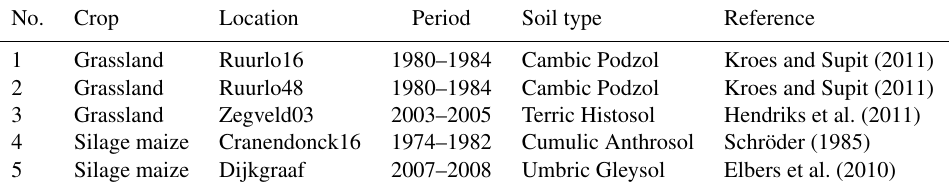
Table 1. Test sets for